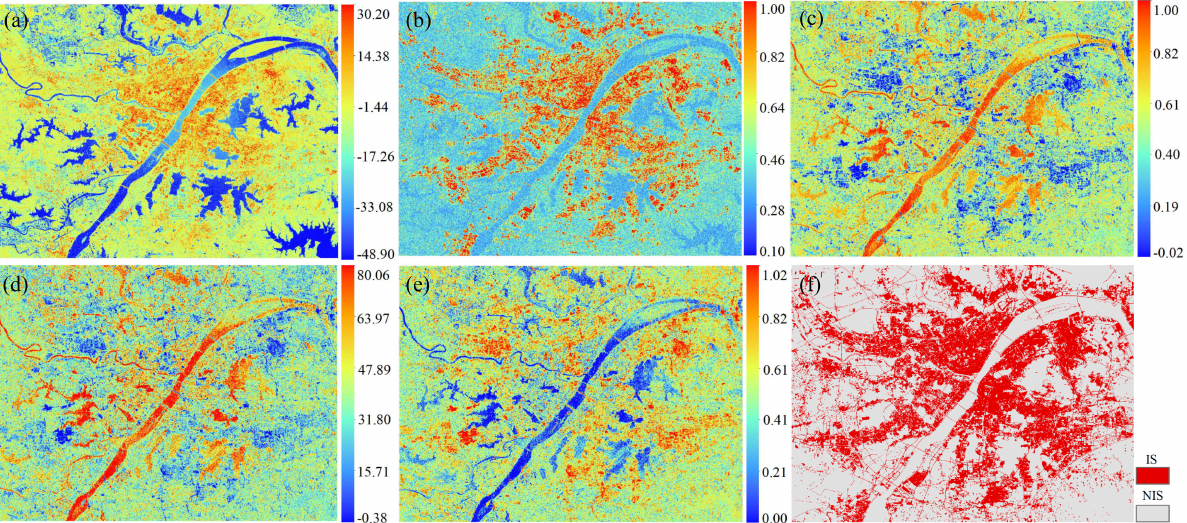
Figure 1. Visualization results of intensity, coherence, and polarization features of ground